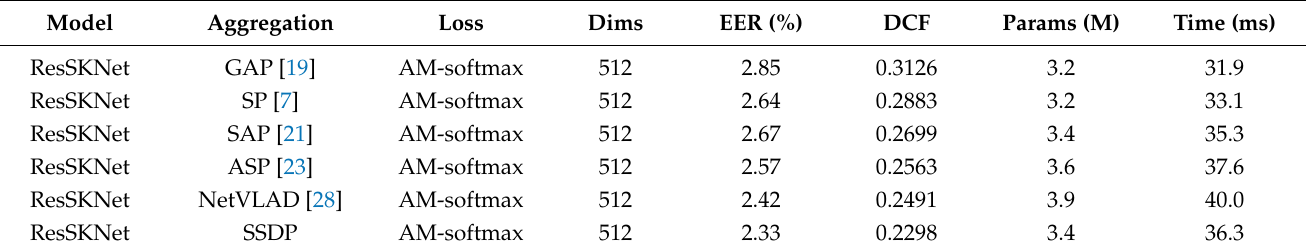
Table 5. Results of aggregation models on Voxceleb1-O.